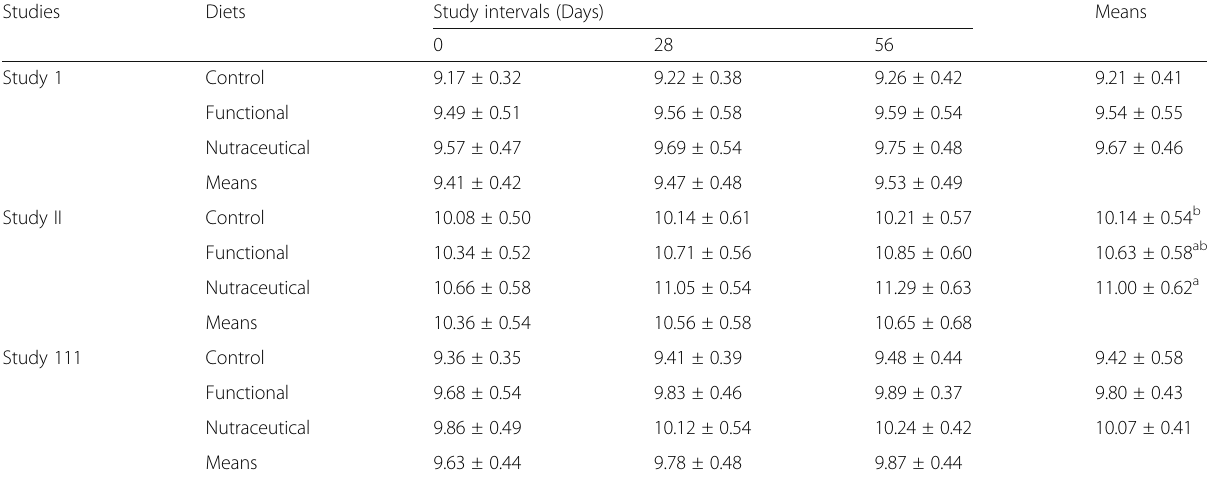
Table 3 Effect of diets and study intervals on insulin level ( μ U/mL) of rats in different studies Studies Diets Study intervals